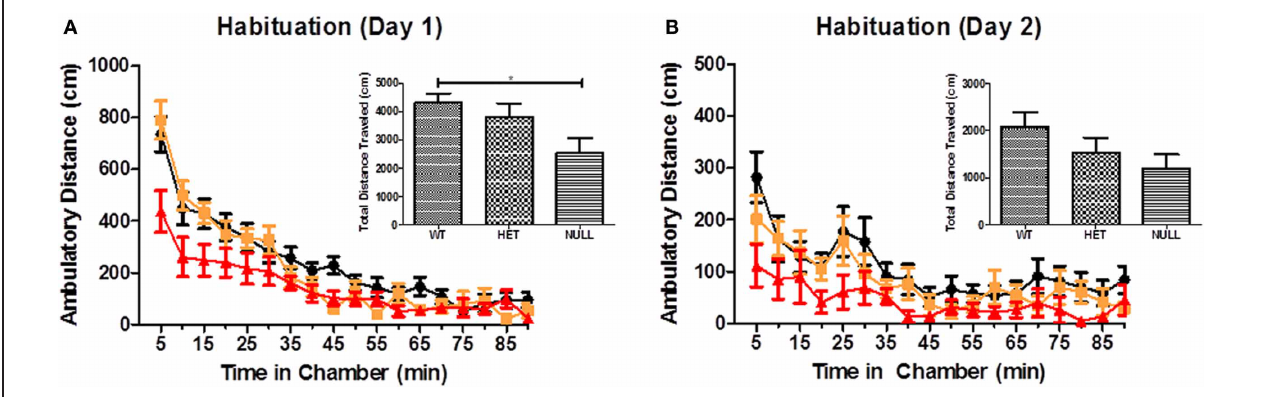
FIGURE 6 | Open field test. Locomotor activity in a novel open field was assessed. (A,B) show the ambulatory distance traveled as a function of time (5min blocks over a 90min testing period) by each genotype on 2 days of habituation. Mice were removed from the chamber after 30min and